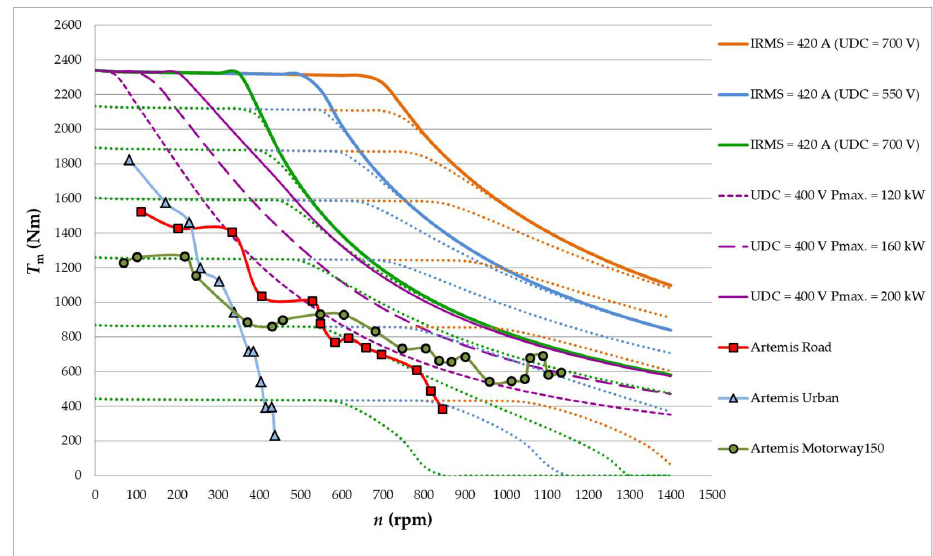
Figure 12. Calculated torque characteristics of the motor for three different supply voltages of the U DC drive with the three limits of the drive input power and the maximum torque characteristics for the given rotational speed of the Artemis Urban cycle, Artemis Road and Artemis Motorway150.